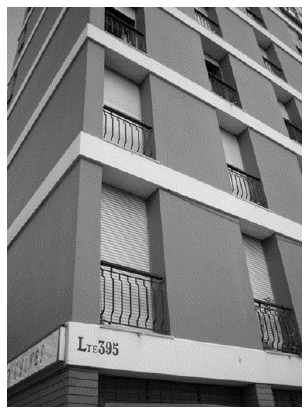
Figure 23. Detail of the windows.